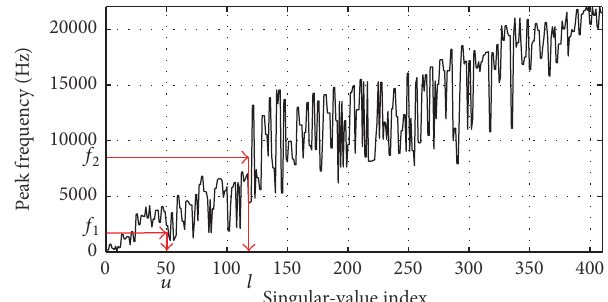
Figure 8: Example of parameter selection: frequency range [𝑓 1 ,𝑓 2 ] is mapped to the interval [𝑢, 𝑙] .